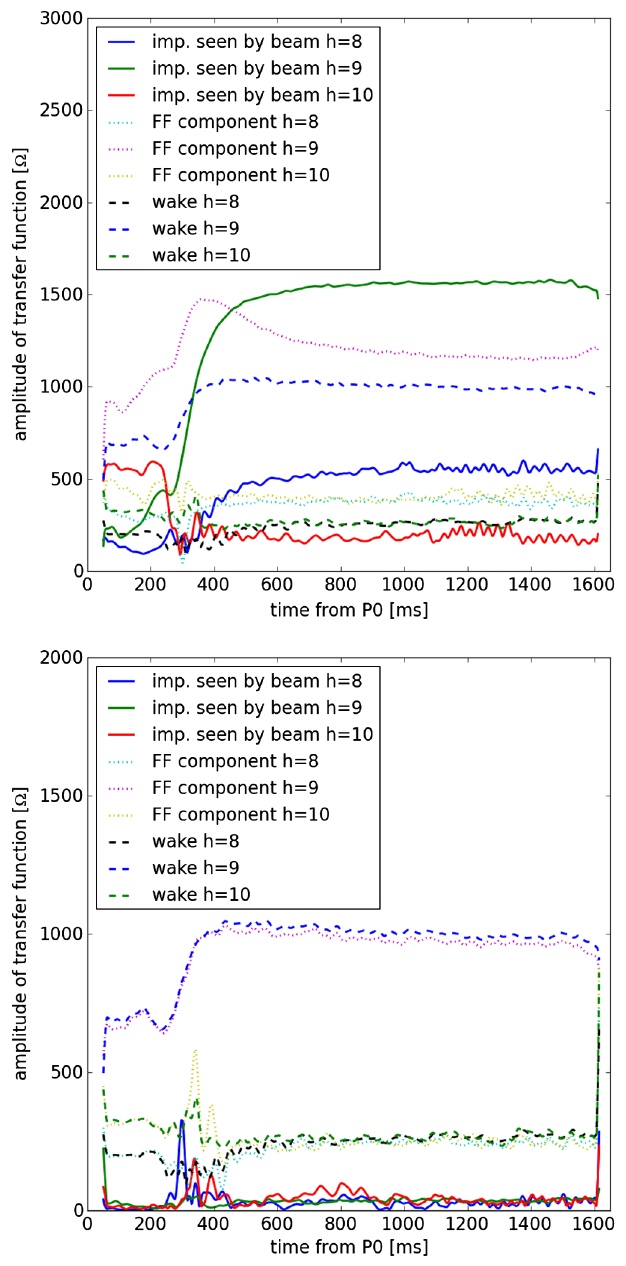
FIG. 9. A comparison of the impedances and the feedforward transfer function of cavity #8: (top) in case of constant gain and phase patterns for all harmonics; (bottom) the result after two iterations.